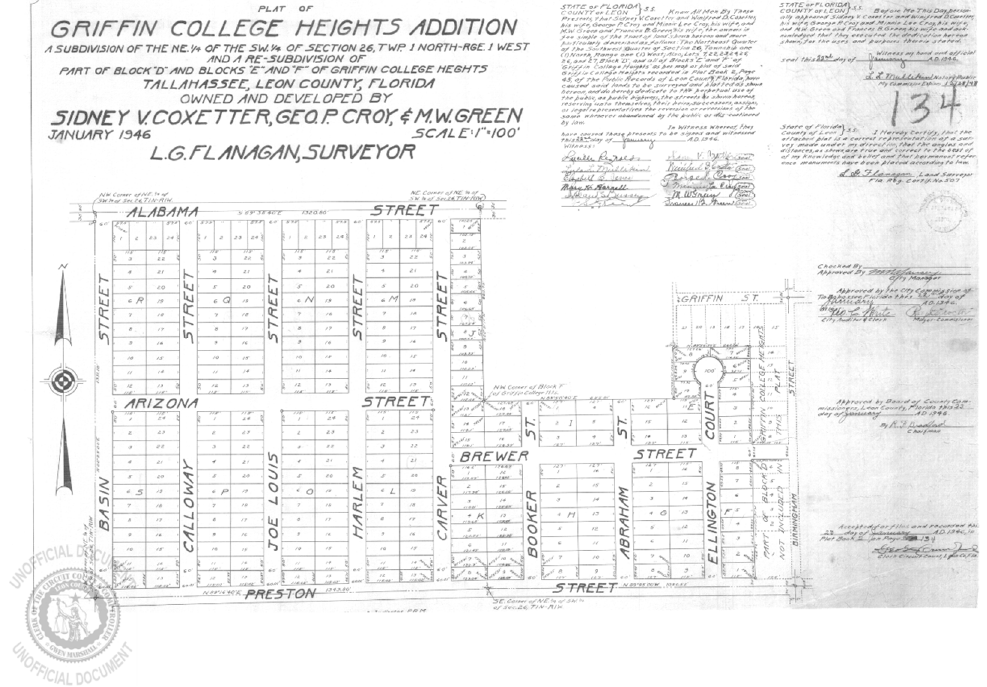
Figure 3. Griffin Heights Original Neighborhood Boundaries (Source: City of Tallahassee). Figure 3. Gri ffi n Heights Original Neighborhood Boundaries (Source: City of